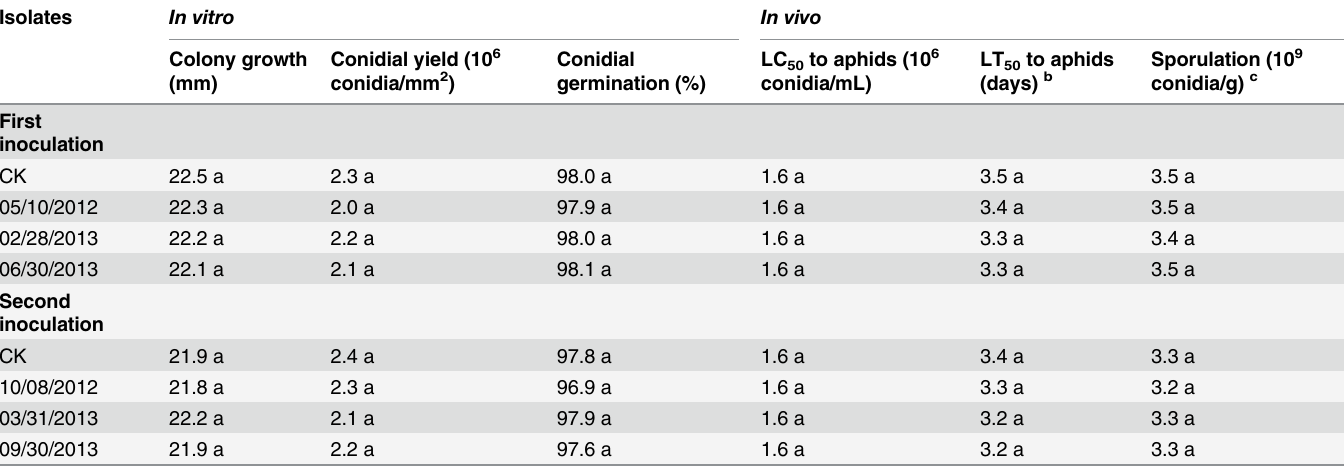
Table 4. Comparison of biological characteristics of original and recovered isolates of L . lecanii a . Isolates